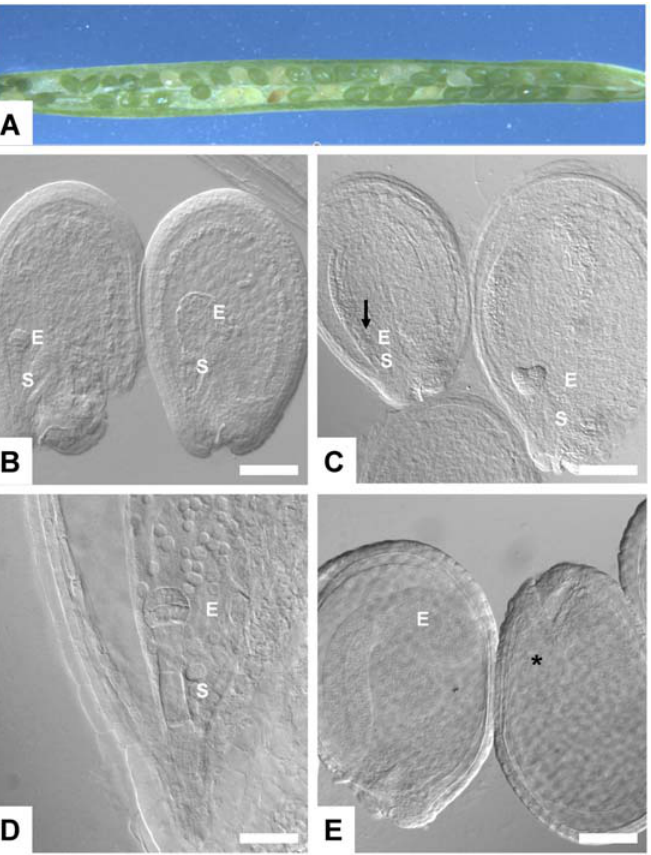
Figure 3. Development of ape1L-1 , ape-2-1 mutant seeds. A. Immature silique produced by self-cross of a plant heterozygous for ape1L-1 and homozygous for ape2-1 . B. Cleared pre-globular stage seeds showing one normally developing seed (left) and one aberrant (right) embryo proper and suspensor phenotype from the same silique; scale bar=80 m m. A number of seeds continue to develop to the heart stage (C) while some seeds remain at the pre-globular stage of development (arrow); scale bar=85 m m. D. Close-up of (C) showing a seed arrested at the pre-globular stage of development; scale bar=15 m m. By the bent cotyledon stage (E) some seeds within the same silique show no visible embryo within the central vacuole (*); scale bar=120 m m. E, embryo proper; S, suspensor.